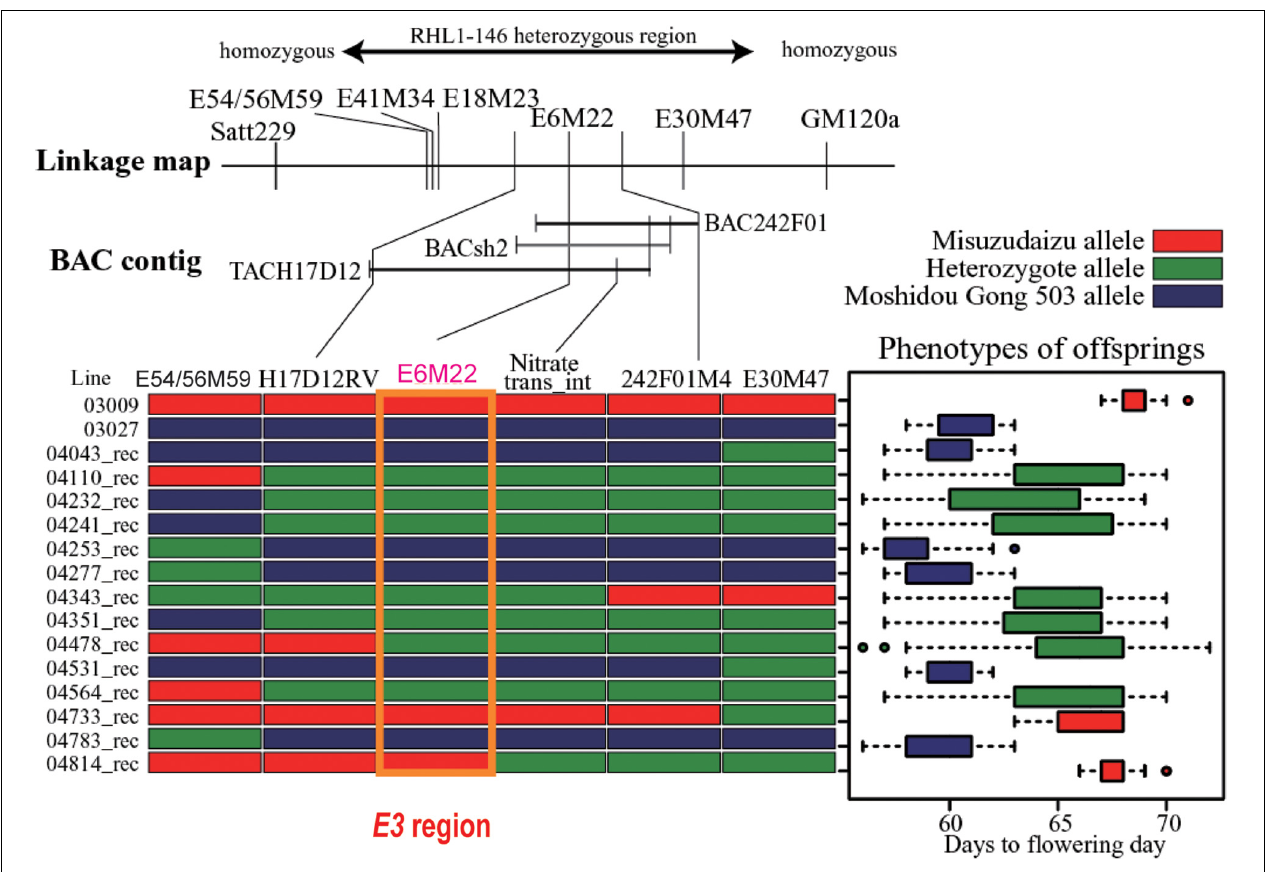
FIGURE 3 | Fine mapping of the E3 gene. The heterozygous region is shown on the top. The linkage map of markers and bacterial artificial chromosome (BAC) contig are displayed in the middle panel. Mapping using recombinants are shown in the bottom panel: left, recombinants detected; right, phenotypic segregation patterns in the progenies. Recombination is shown by red bars representing homozygous Misuzudaizu allele, blue bars representing homozygous Moshidou Gong 503, and green bars representing the heterozygote. The phenotypic segregation is shown in boxplot format. The delimited E3 region is shown in the purple box (Adapted from Watanabe et al.,